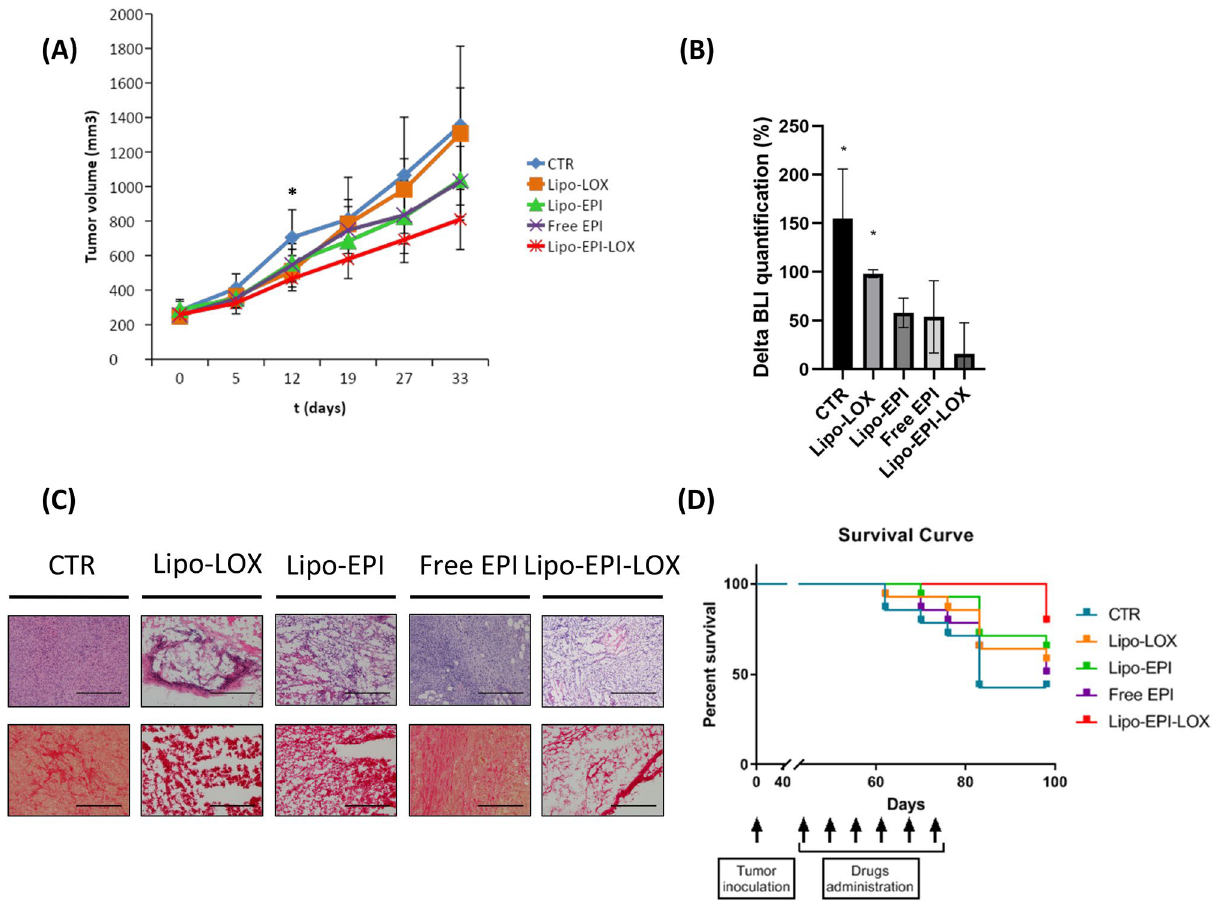
Figure 4. ( A ) Tumor growth curves of orthotopic xenograft mouse model of human TNBC. Five group mice ( n = 10 each group) treated with empty liposome (CTR), Lipo-LOX, LIPO-EPI, free EPI and Lipo-EPI-LOX. ( B ) Delta quantification of TNBC bioluminescent signal after 4 weeks of treatment. ( C ) Representative example of H&E stained sections of explanted tumors 55 days post treatment. Control: markedly atypical and pleomorphic cells (5% necrotic tumor cells). Scale bar is 400 µm. Lipo-LOX: fibrotic tissue with atypical cells and neoplastic crown (25% necrotic tumor cells). Lipo-EPI: Neoplastic cells and necrotic bands (50% necrotic tumor cells). Free EPI: tumor cells infiltrating adipose tissue with minimal necrotic features e limited inflammation (20% necrotic tumor cells). Lipo-EPI-LOX : tumor cells infiltrating adipose tissue with artifacts (60% necrotic tumor cells). Representative example of collagen stained sections of explanted tumors 55 days post treatment. Control: collagen fibers linearization ˃ 200 µm, Lipo-LOX collagen fibers linearization ˂ 200 µm, Lipo-EPI collagen fibers linearization ˃ 200 µm, free EPI collagen fibers linearization ˃ 200 µm, Lipo-EPI-LOX collagen fibers linearization ˂ 200 µm. Scale bar is 400 µm. ( D ) Kaplan–Meier curve indicating survival in tumor-bearing mice after tumor induction in the listed treatment groups (Control, Lipo-LOX, LIPO-EPI, free EPI and Lipo-EPI- (BLI) of TNBC tumors at day 0 and day 33 (Fig. 4B, Supplementary Fig. 5). This was performed to support the caliper measurements since the bioluminescent signal obtained from BLI is directly related to the viability of cells and it could serve as a metric to evaluate the impact of therapy 39 . The BLI quantification percentage (D0 vs D33) was found to be statistically significant in CTR ( p = 0.01) and Lipo-LOX ( p = 0.01) groups, while free EPI ( p = 0.24), Lipo-EPI ( p = 0.09) and Lipo-EPI-LOX ( p = 0.35) did not result in statistical significance. Notably, the lowest BLI quantification percentage was observed with the Lipo-EPI-LOX treatment group. As in clini- cal practice, these experiments confirmed that anthracycline-based regimens can slow down mammary cancer progression and demonstrated that LIPO-EPI-LOX treatment provides superior antitumor efficacy among all treatment groups. The decreased viability detected by BLI analysis was further confirmed by hematoxylin and eosin (H&E) staining of tumor sections and they were analyzed for the percentage of necrotic cells. In particular, necrotic tumor cells were 5% in the control group, 25% in Lipo-LOX, 50% in Lipo-EPI, 20% in free EPI, and 60% in Lipo-EPI-LOX treated tumors (Fig. 4C). These experiments confirmed the superior ability of Lipo-EPI- LOX in inducing tumor necrosis compared to other treatment conditions. Moreover, since previous works 4,40 have demonstrated that the progressive linearization of collagen fibers adjacent to tumor lesions is linked to collagen crosslinking, ECM stiffening, and increased focal adhesions, we investigated the collagen of explanted tumors. The analysis showed higher collagen linearization in CTR, Free EPI, and LIPO-EPI while a decrease in